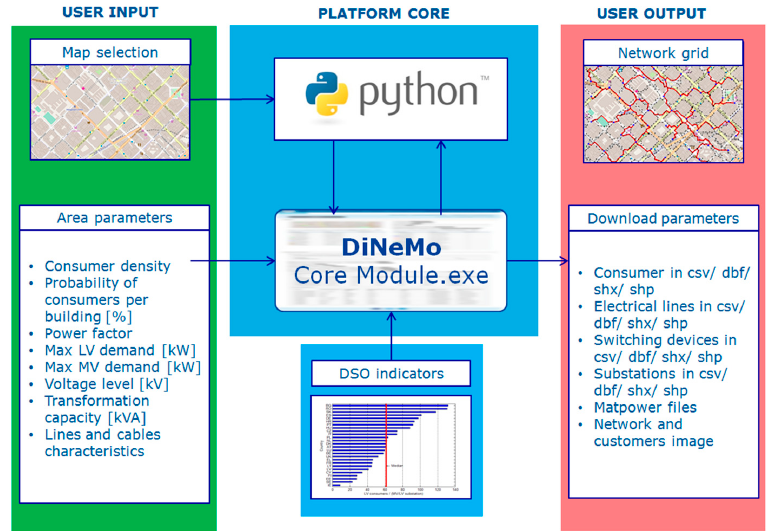
Figure 1 DiNeMo platform input, core module, and output structure. Figure 1. DiNeMo platform input, core module, and output